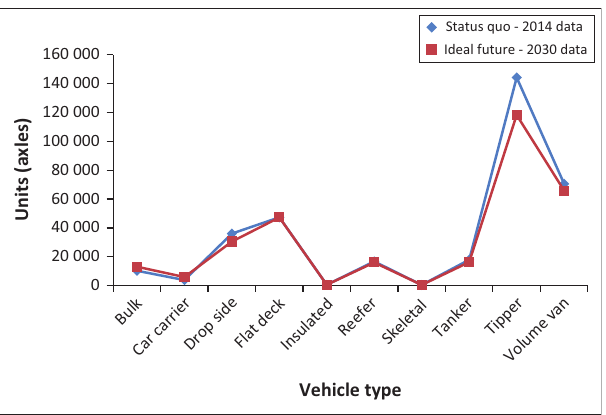
FIGURE 5: Summary of South Africa’s heavy goods vehicle fleet – 2014 actuals versus 2030 ideal future